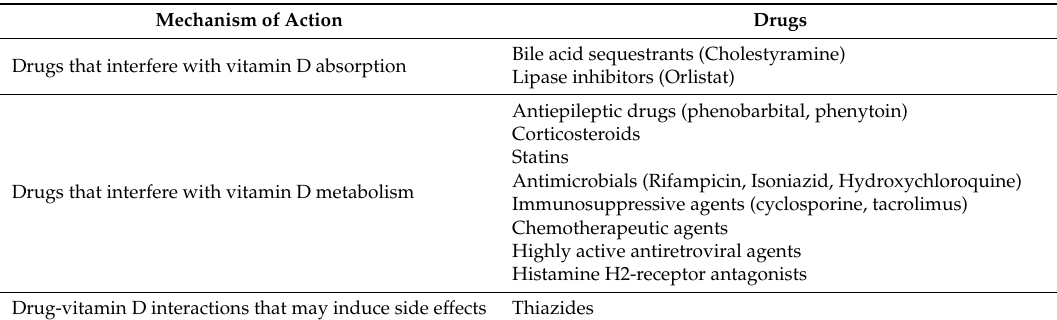
Table 2. Vitamin D and drugs